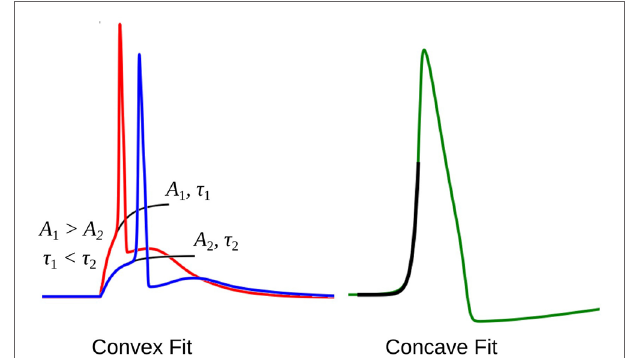
FIgURe 6 | The exponential fit for two convex footed APs (left) and one concave footed AP (right). The comparison of the fitting parameters corresponding to the two convex foots are also shown. See text for details.